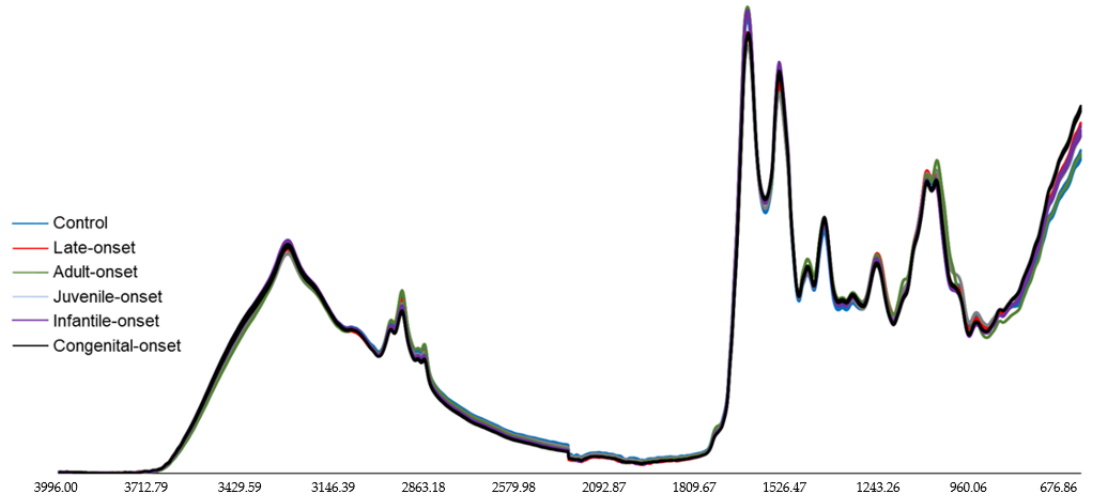
Figure 4. FTIR spectra of DM1-derived fibroblasts and control from Neurolab UA. Baseline-corrected and area normalized spectra of DM1-derived fibroblasts and control in the 4000–600 cm − 1 region. X -axis:wavenumber cm − 1 , Y -axis: arbitrary units (AU).